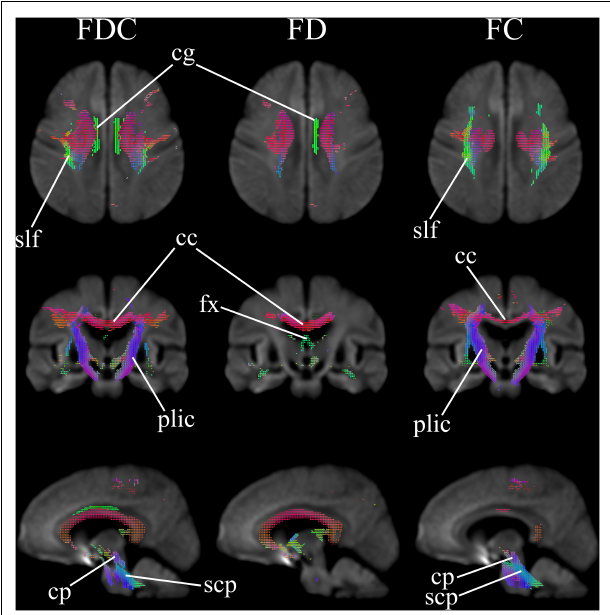
FIGURE 1 | Areas of significant reductions in fiber density and cross-section (FDC), fiber density (FD), and fiber bundle cross-section (FC) in patients with Huntington’s Disease compared to healthy control participants, displayed in the axial, coronal, and sagittal views. Significant fixels (family-wise error corrected p < 0.05) are illustrated and colored according to fiber direction. FDC, fiber density and cross-section; FD, fiber density; FC, fiber bundle cross-section; cg, cingulum; slf, superior longitudinal fasciculus; cc, corpus callosum (forceps minor, major, and corona radiata white matter fibers); fx, fornix (pre- and post-commissural fibers); plic, posterior limb of internal capsule (corticospinal fibers and middle thalamic radiation); cp, cerebral peduncles (extrapyramidal tracts); scp, superior cerebellar peduncles (extrapyramidal